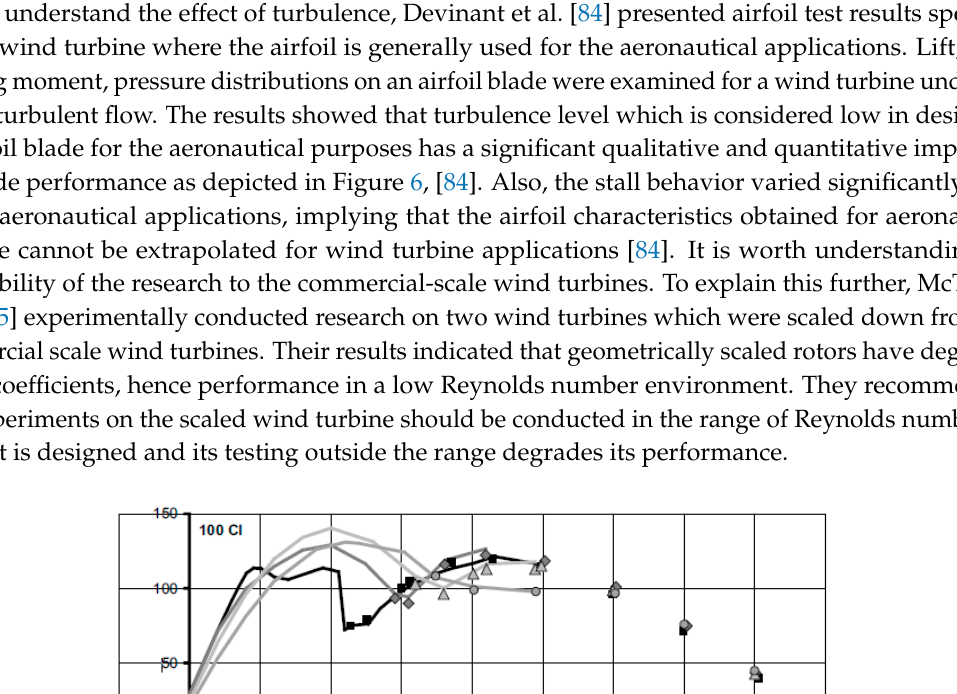
L of wind turbine a Re = 400,000